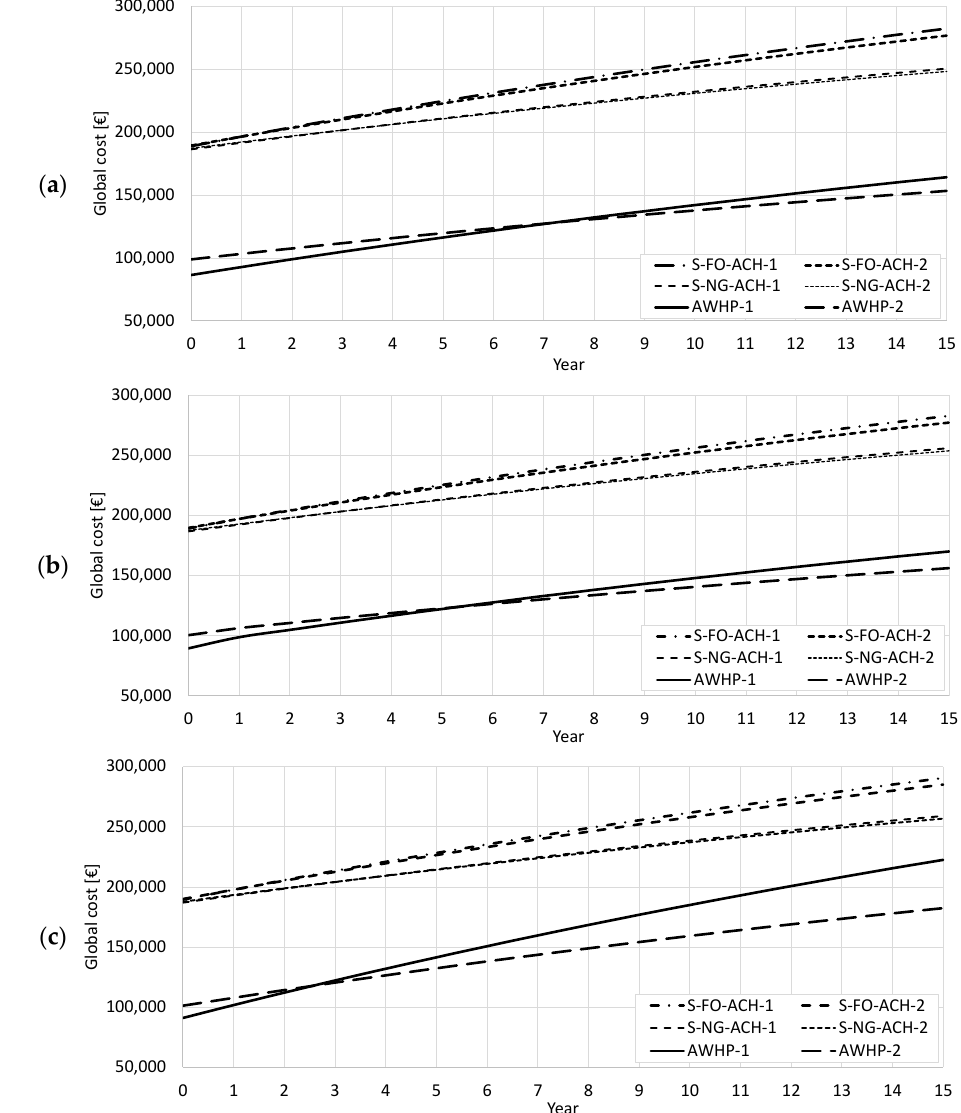
Figure 14. Lifetime costs for considered energy price scenarios: ( a ) S1, ( b ) S2, ( c ) S3.